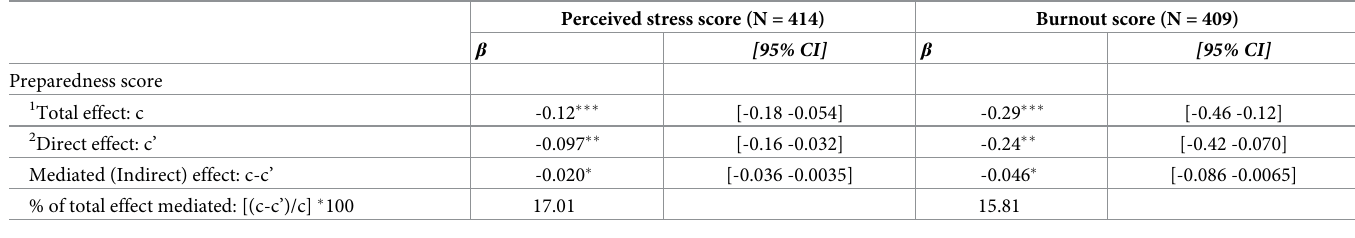
Table 5. Mediation by fear of infection among healthcare workers in